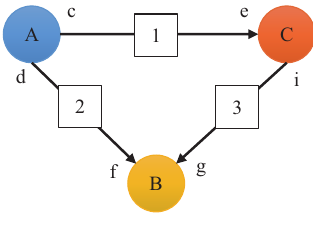
Figure 2. An example of